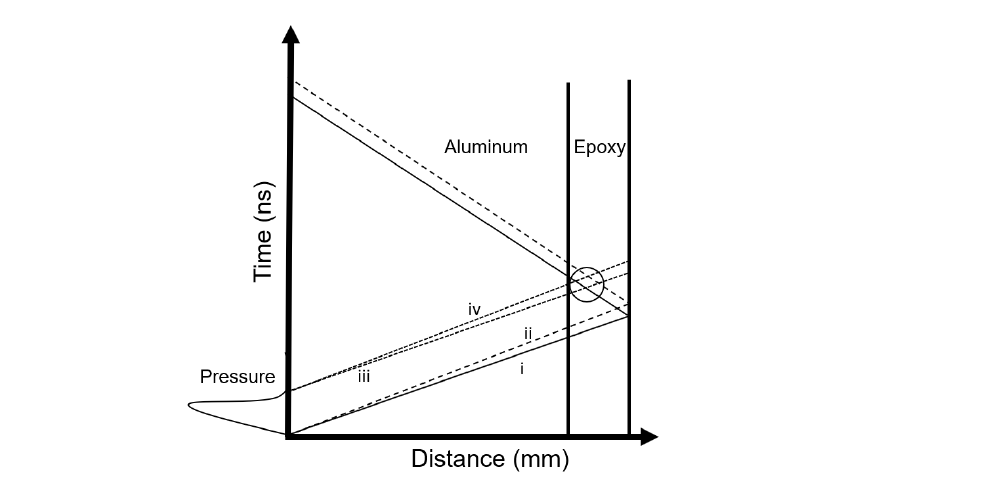
Figure 2. Schematic illustration of the shock wave propagation into the aluminum/epoxy system. (i) Elastic precursor, (ii) plastic shock, (iii) elastic decompression shock and (iv) plastic decompres- sion shock.